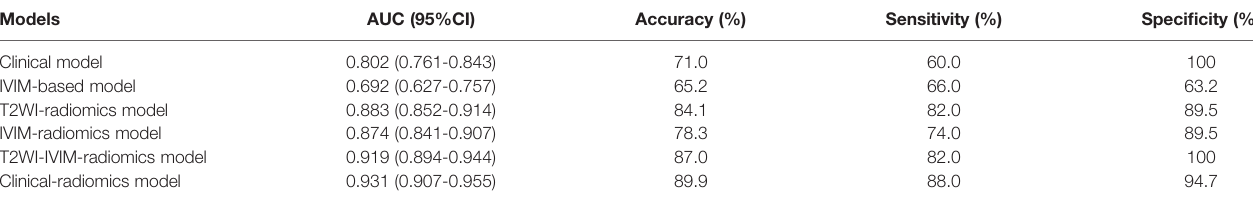
TABLE 3 | The performance of various diagnostic models. Models